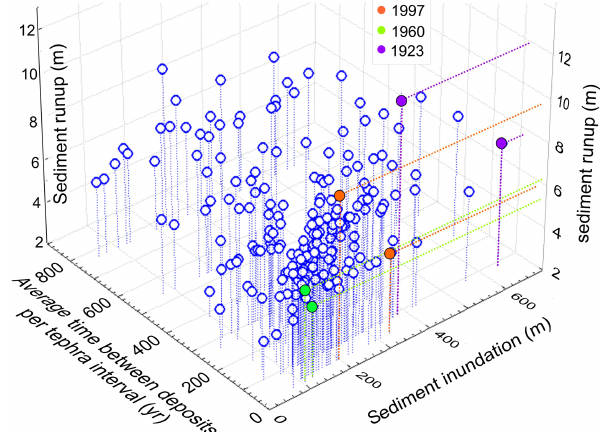
Figure 10. Three-dimensional diagram summarizing sediment runup and inundation for tsunami deposits, south Kamchatsky Bay, above KS 1 tephra ( ∼ AD300 up through AD2000; from data plot- ted in Figs. S7 and S8). The three historical tsunami deposits are highlighted with their two points of maximum runup (and corre- sponding inundation at that point) and maximum inundation (and corresponding runup at that point), which do not coincide. For pre- historic events, we calculated (sediment) runup and inundation per tephra interval, with adjustments for changes through time in shore- line location and excavation elevation (see text and Fig.